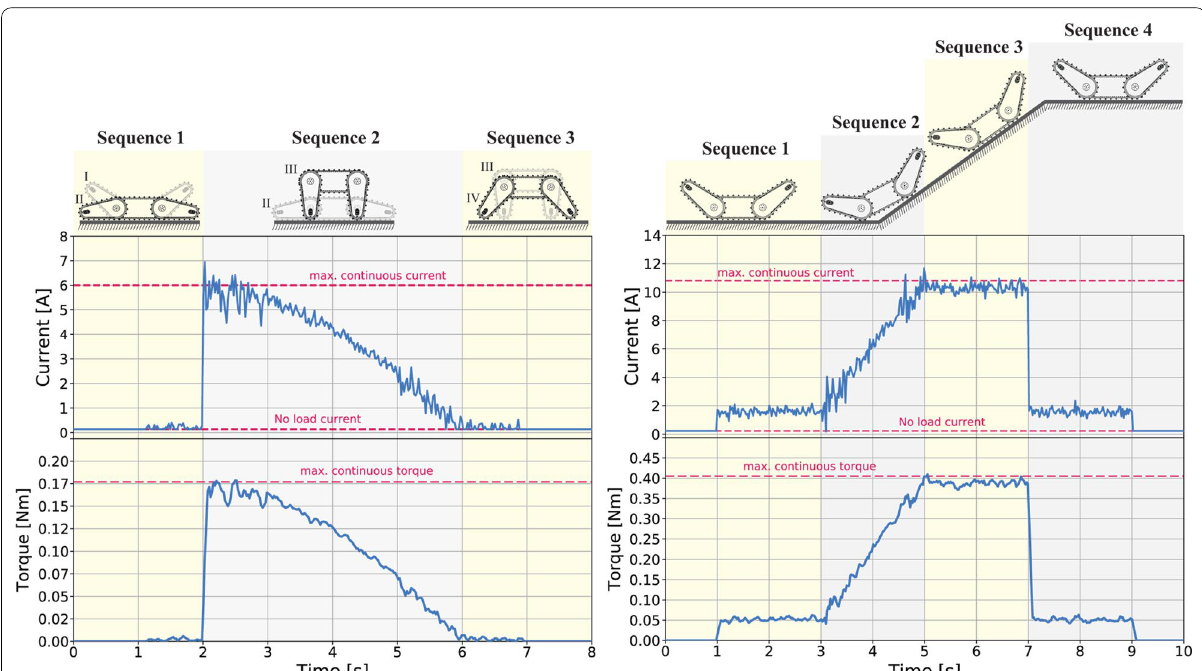
Fig. 18 Feedback current and corresponding torque of the traction motor during ramp (40°) climbing (right) and the flipper motor during a course of rotation